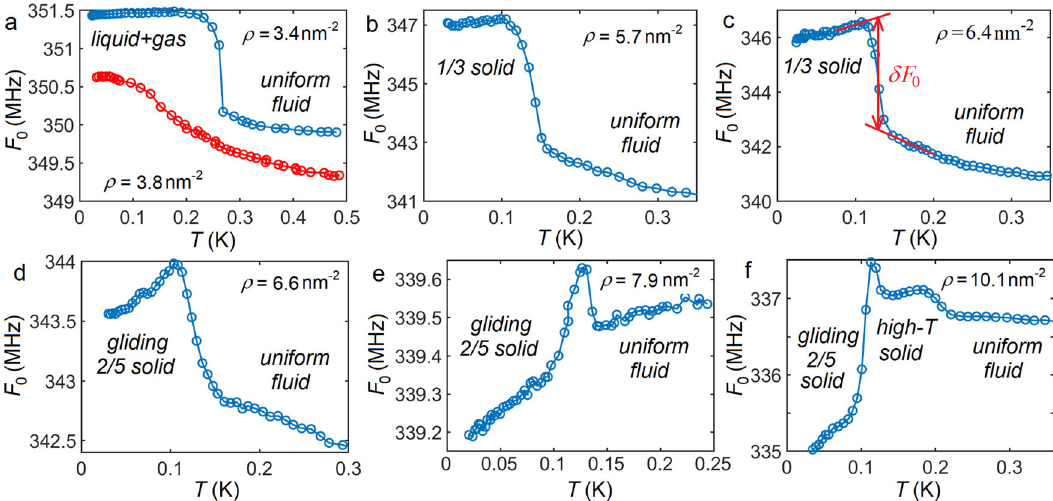
Fig. 1 | Phase transitions observed as a jump of the resonant frequency F 0 at different helium coverages. a Transitions from the liquid+gas coexistence to a uniform fl uid.Thejumpof F 0 isduetoredistributionofheliumfromliquidclusters to uniform. b , c Melting of the rigid 1/3 solid manifested by the reduction of the stiffnessoftheoscillator.Thepanel c alsoillustratesthemeteringofthejump δ F 0 at thetransition. d , e Meltingofthediscoveredglidingsolidphasewithnomeasurable